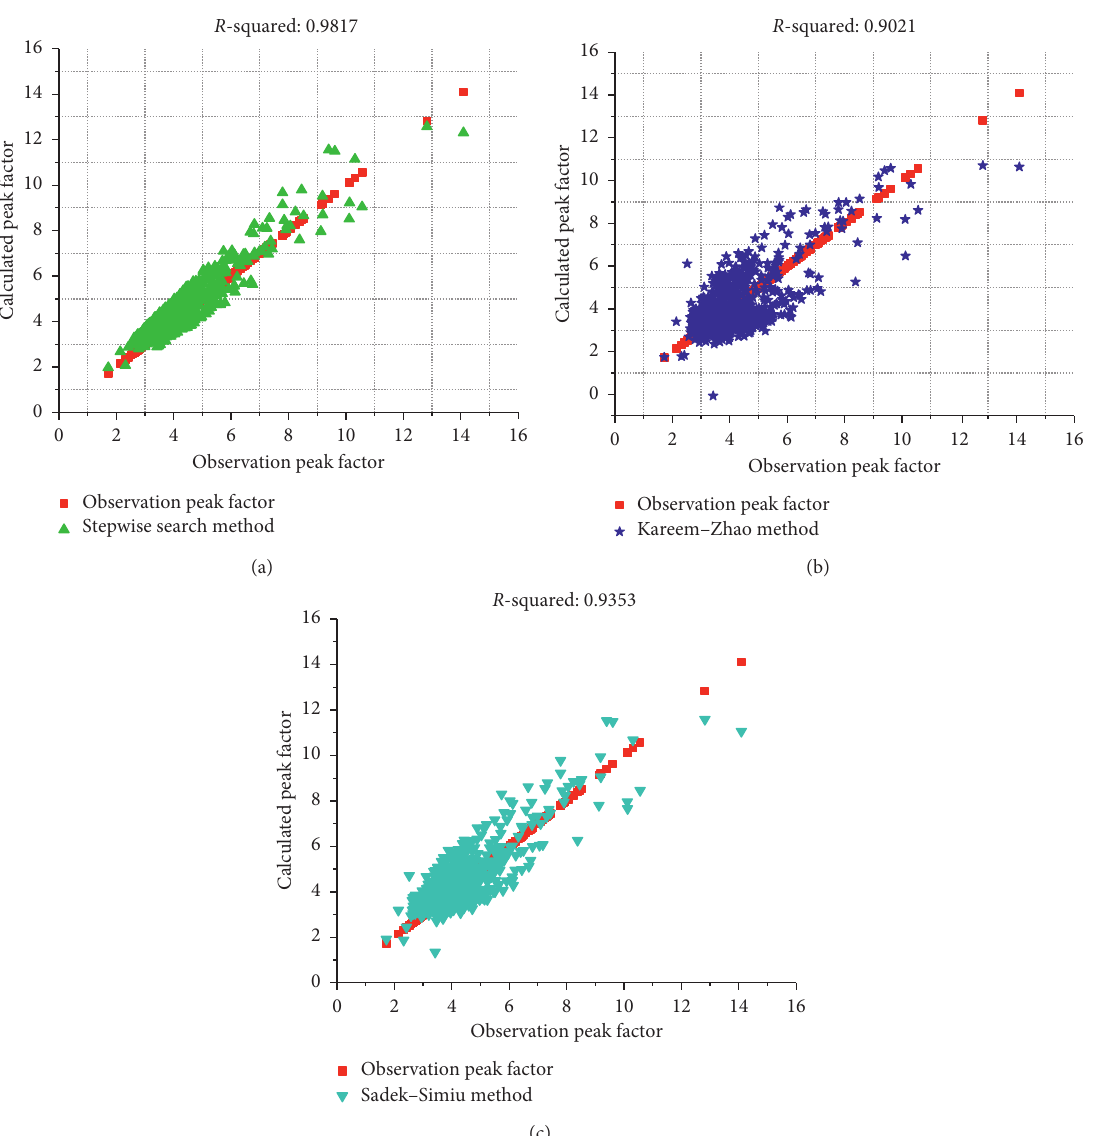
Figure 11: Peak factor of 808 measurement points calculated by different methods at a 90 ° wind direction angle. (a) Comparison of stepwise search method peak factor and observed peak factor. (b) Comparison of Kareem-Zhao method peak factor and observed peak factor. (c) Comparison of Sadek–Simiu method peak factor and observed peak factor.